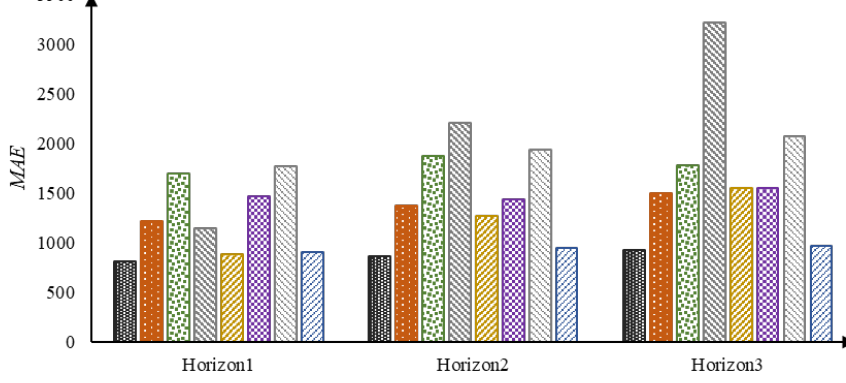
Figure 10. RMSE of each model in multi-step-ahead forecasting in discussion.